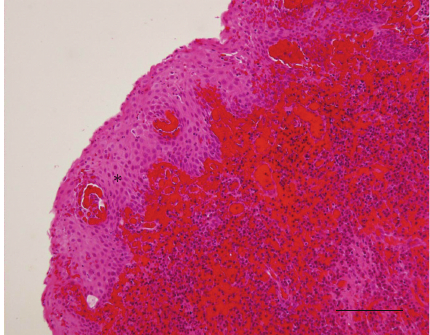
Figure 2: Pathological findings reveal lining squamous epithelium (asterisk) and inflamed tissue with lymphocytes and plasma cells. The bar indicates 100 µ m. Hematoxylin and eosin